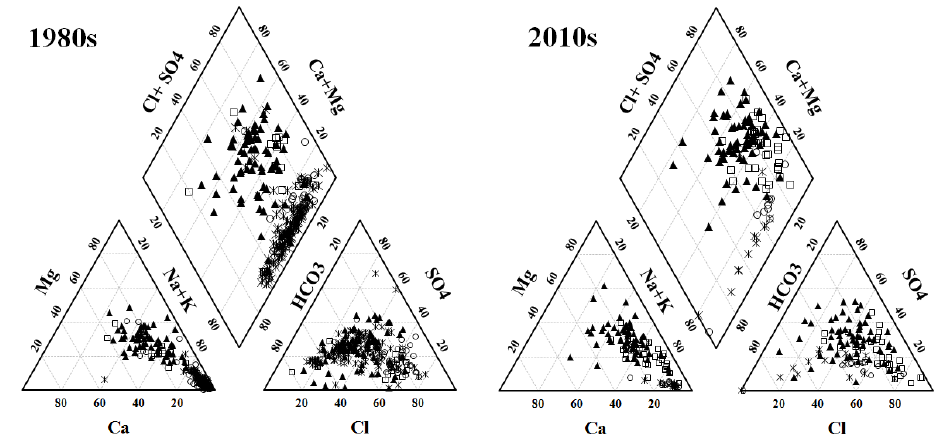
Figure 6. Piper plots of shallow and deep groundwater samples among decades.